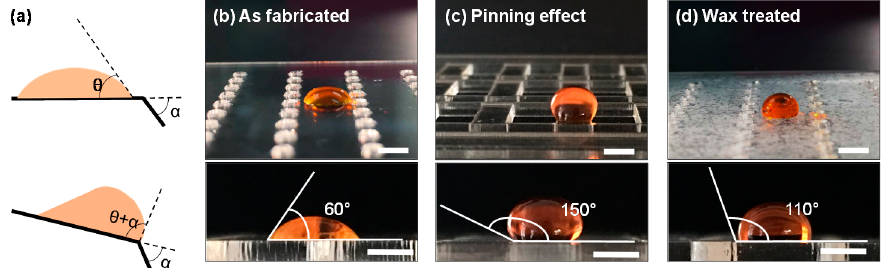
Figure 2. Pinning effect and chip surface treatment. ( a ) A droplet on a solid surface with a contact angle of θ , which will be increased up to θ + α when moving towards a three-phase edge; ( b ) The as-fabricated PMMA chip shows a contact angle of 60°; ( c ) The droplet pinned on the sample-loading chip shows a 150° contact angle; ( d ) The wax treated auto-aliquoting chip shows a contact angle of 110°. The scale bars in the images are 3 mm.